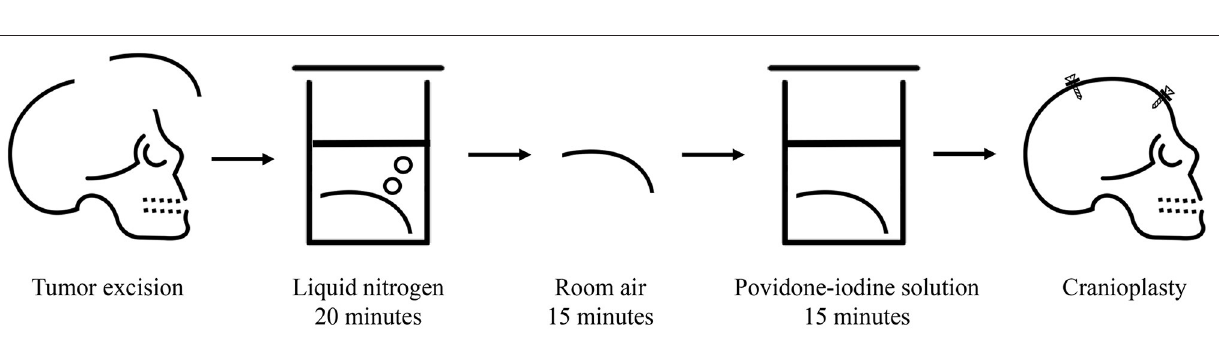
FIGURE 3 | Summary of the ex vivo